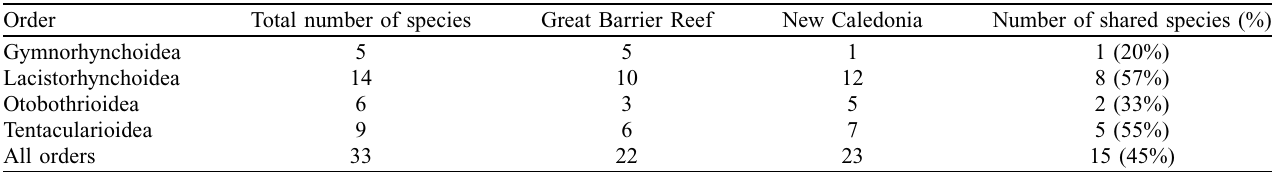
Table 3. Summary of the fully identified taxa of larval trypanorhynch cestodes found in teleost fishes from the Great Barrier Reef and from New